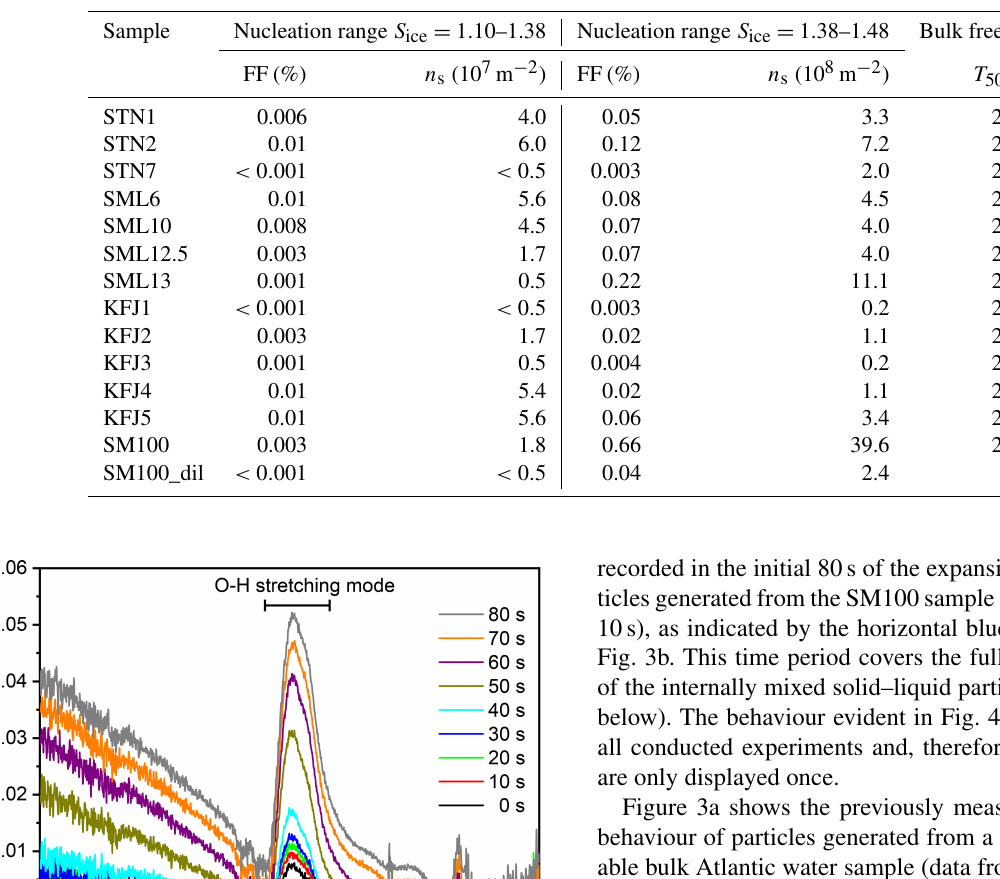
Table 3. Quantitative analysis of the AIDA expansion cooling runs started at 229K. As discussed in the text, the observed heterogeneous ice nucleation modes were separated into two nucleation ranges: (i) S ice = 1 . 10–1.38 and (ii) S ice = 1 . 38–1.48. For both ranges, the maximum values of the ice-active fraction of the aerosol particles, FF, and the ice nucleation active surface site density, n s , were evaluated. The last column summarises the T 50 freezing temperatures from the cold-stage freezing measurements with 50µL aliquots of the bulk solutions.